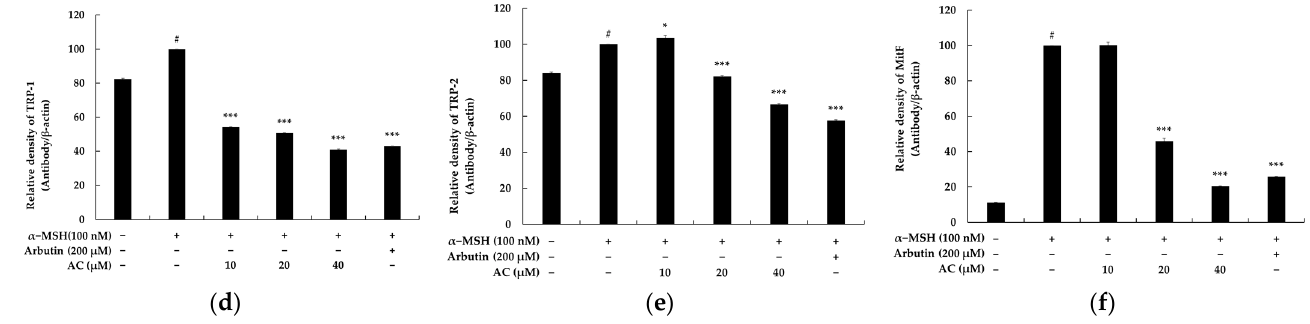
Figure 3. The effect of acenocoumarol on tyrosinase, TRP-1, TRP-2, and MITF protein expression in α -MSH-stimulated B16F10 cells. α -MSH was used as the negative control and arbutin (200 µ M) was used as the positive control. ( a , b ) Protein expression levels of TYR, TRP-1, TRP-2, and MITF were determined by Western blot following with acenocoumarol (10, 20 and 40 µ M) treatment for 48 h in the presence of α -MSH (100 nM). The densitometric analysis of TYR ( c ), TRP-1 ( d ), TRP-2 ( e ), and MITF ( f ) using Image J and present the results as mean ± SD. Statistical significance was expressed as follows: # p < 0.001 vs. unstimulated control group, * p < 0.05, *** p < 0.001 vs. α− MSH alone.